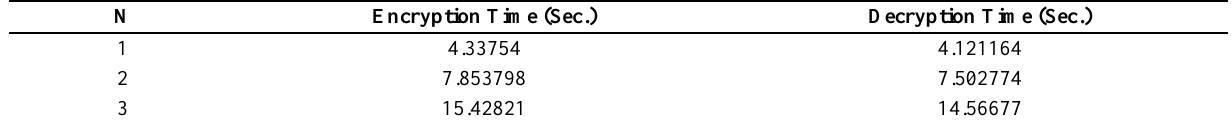
Table 7. Encryption and decryption time of the proposed